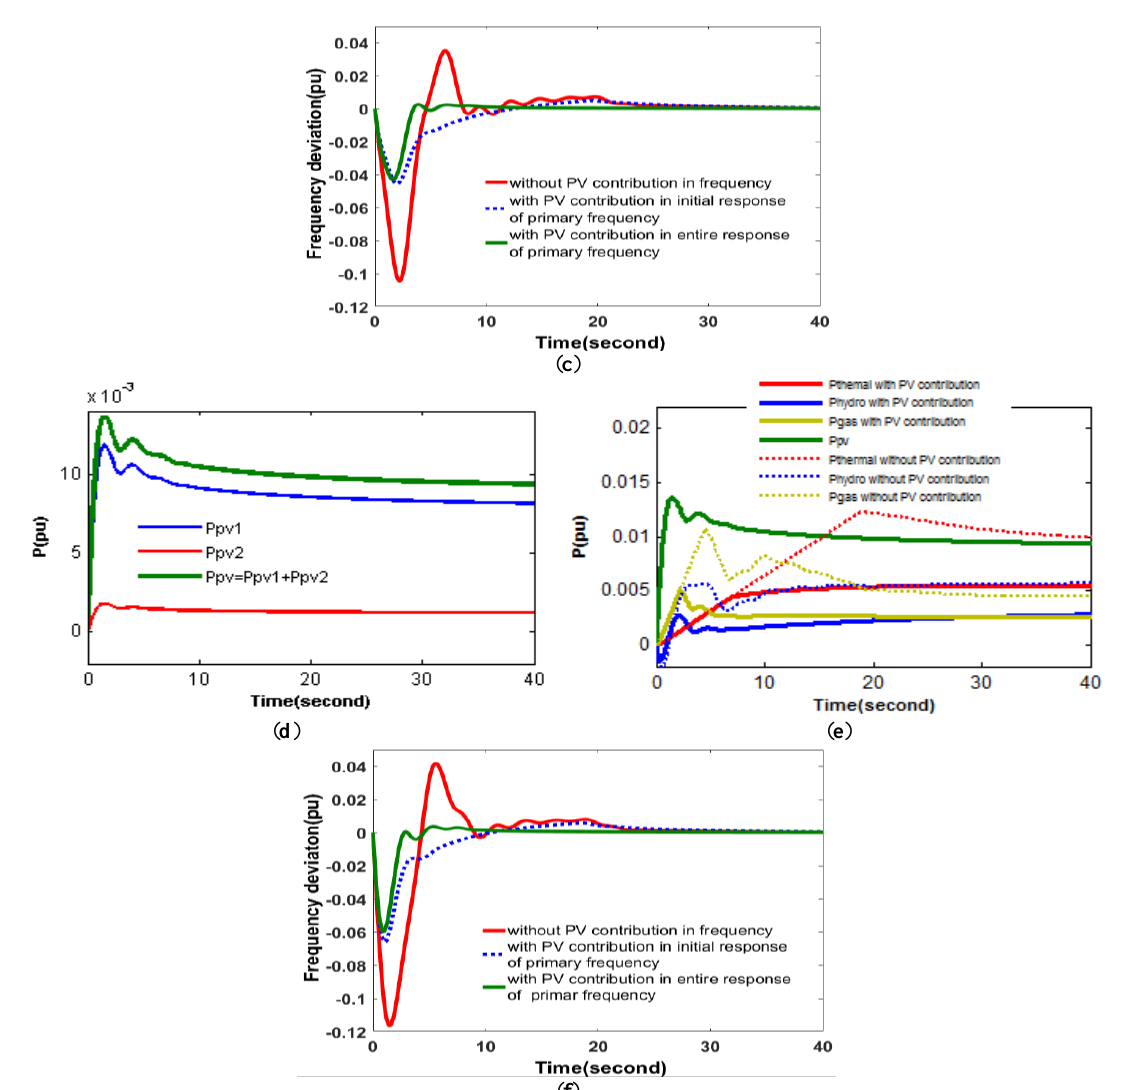
Figure 12. System response to PV contribution in primary frequency control with a 1% rise in step load in power system area 1 and a 2% rise in step load in power system area 2: ( a ) Power variation of the PV modules in area 1; ( b ) Power variation in different units in area 1; ( c ) Frequency of the system in area 1; ( d ) Power variation of the PV modules in area 2; ( e ) Power variation in different units in area 1; ( f ) Frequency of the system in area 2.